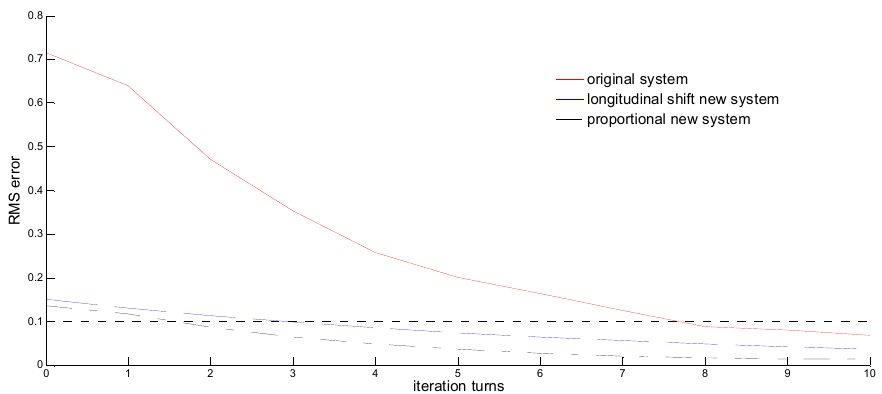
Figure 11. PD-ILC/Sine Curve of Experience Amplitude Adjusting Figure 11. PD - ILC/Sine Curve of Experience Amplitude Adjusting Transform.